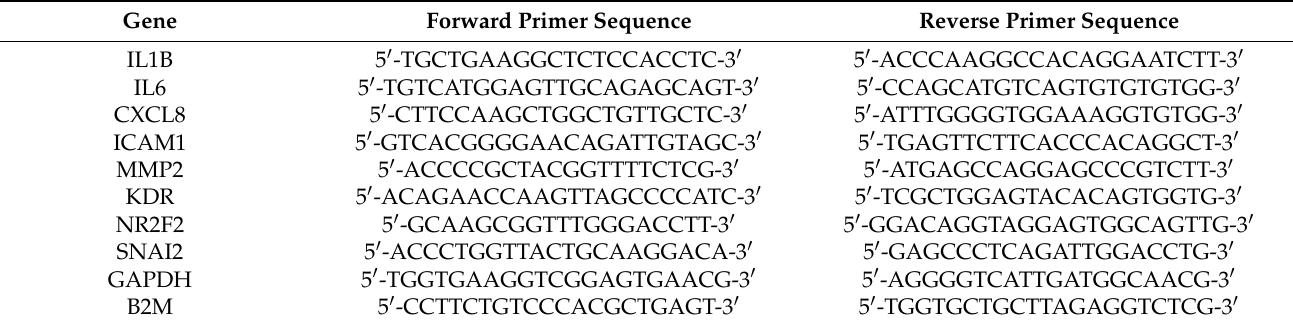
Table 1. Sequences of customised primers for